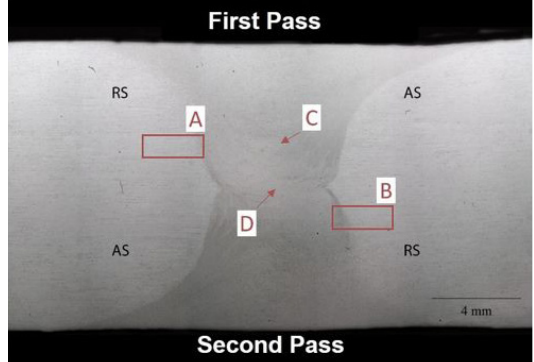
Figure 5. Macroscopic view of a representative joint of AA2050-T84 joint. AS and RS are the short writings for advancing and retreating side, respectively, and the regions indicated as A, B, C and D are shown in higher magnifications in Figure 6.